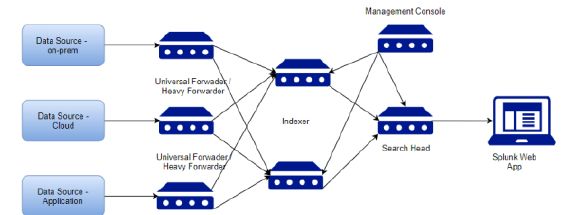
Figure 1. Splunk Sample Architecture